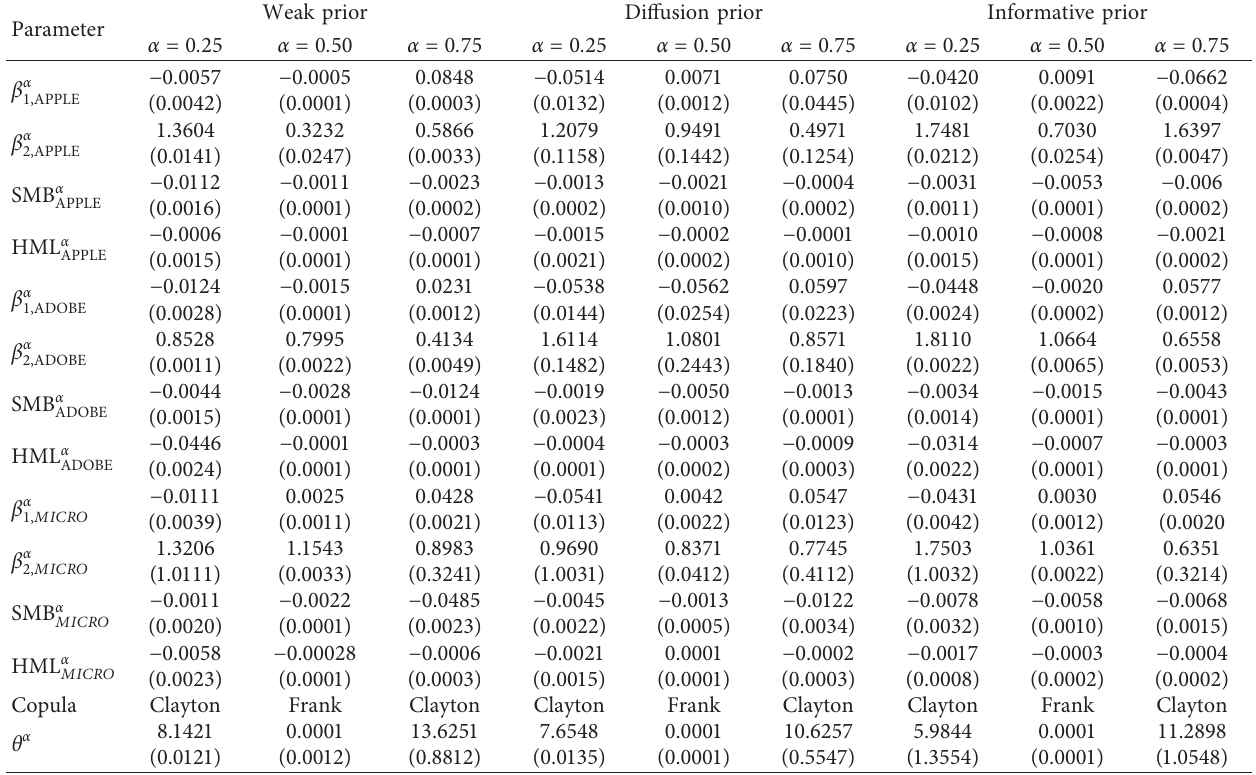
Table 9: Estimates of the parameters and their standard errors.